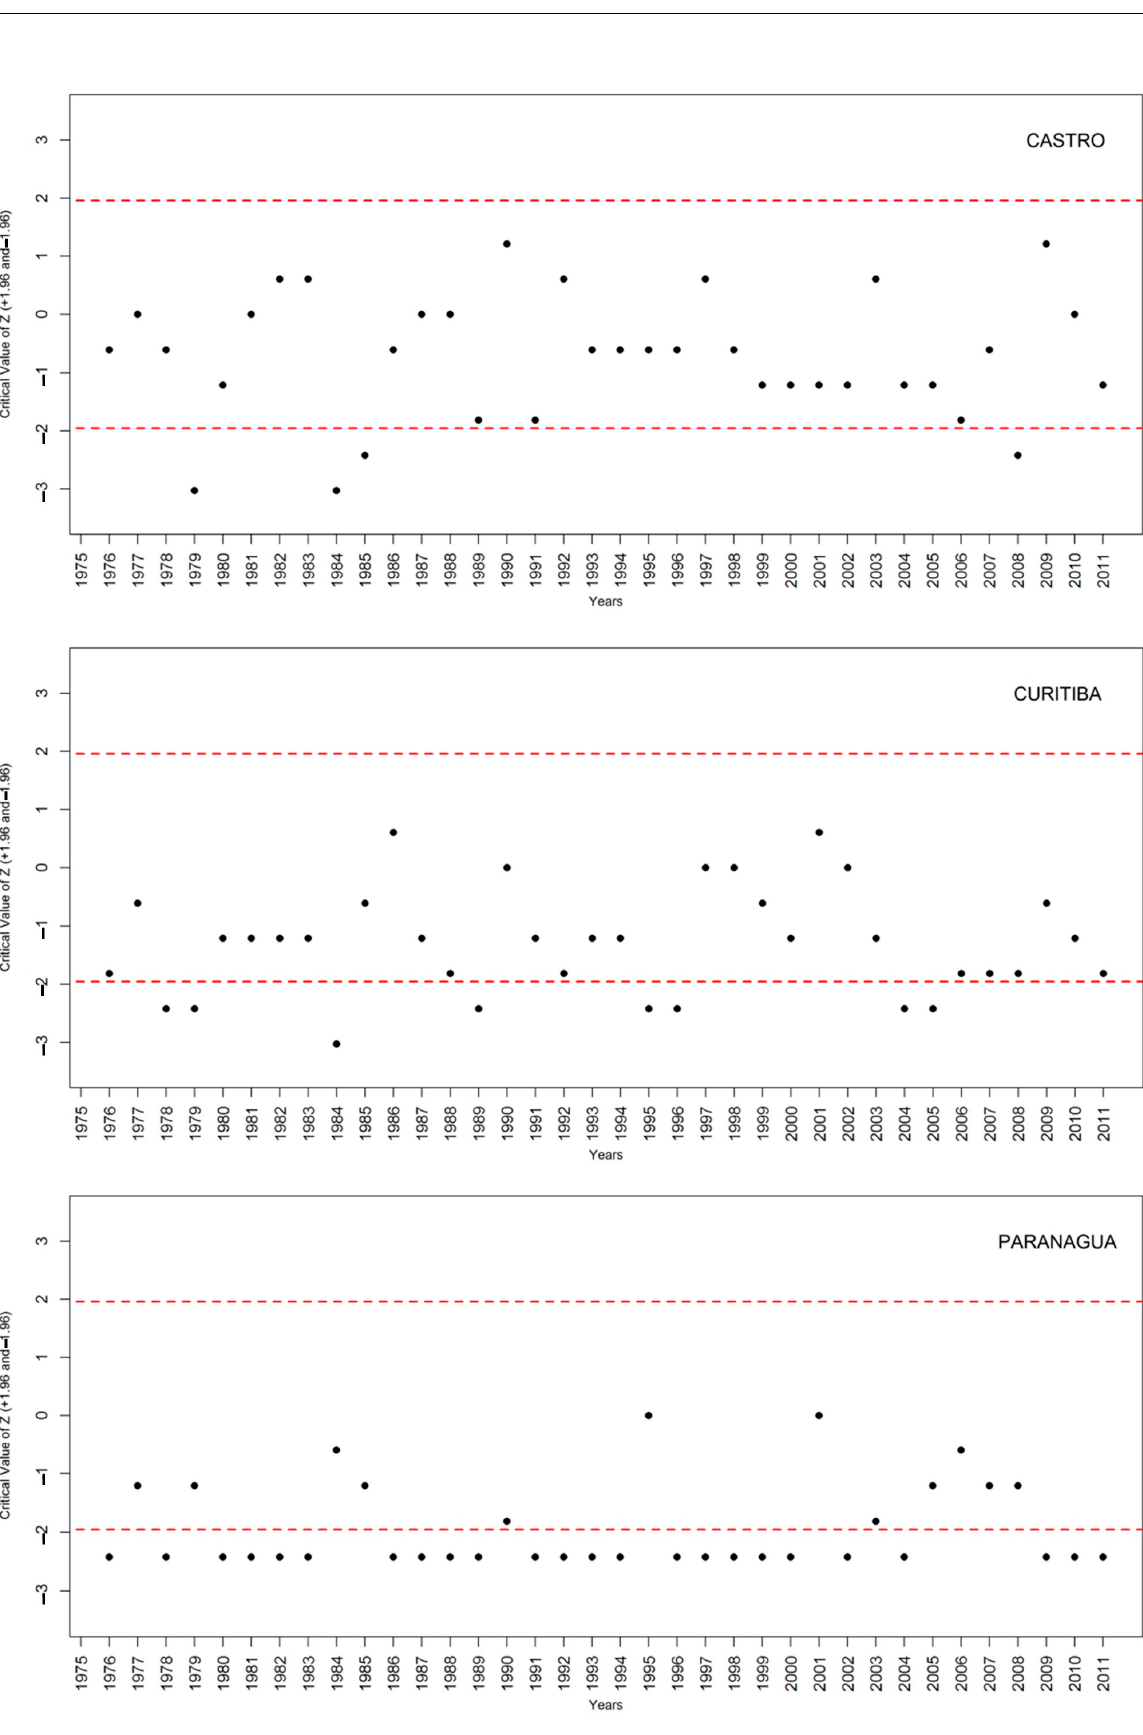
Figure 5. Run test results in the annual scale.